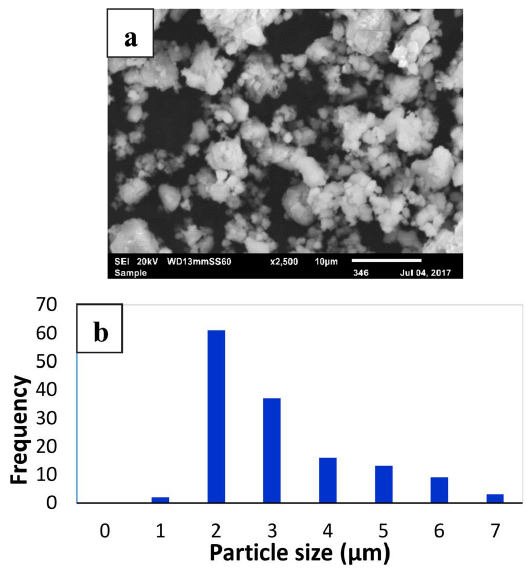
Figure 1. S scanning electron microscope (SEM) micrograph showing the morphology of ball-milled complex composition alloy (CCA) particles in ( a ) and the graph showing particle distribution in ( b ).